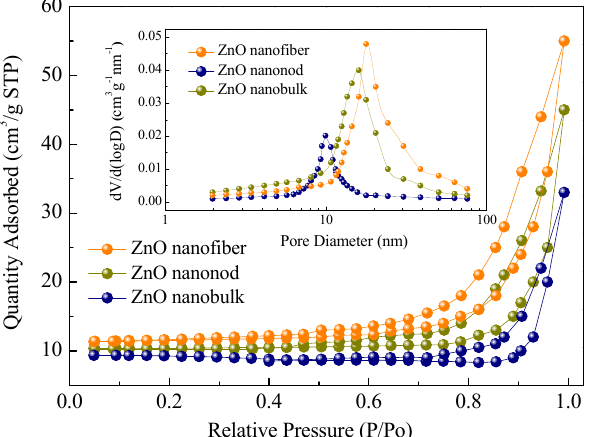
Figure 8. Nitrogen adsorption-desorption isotherms of ZnO nanorods, nanofibers and nanobulks. The inset to the figure shows the corresponding pore size distribution